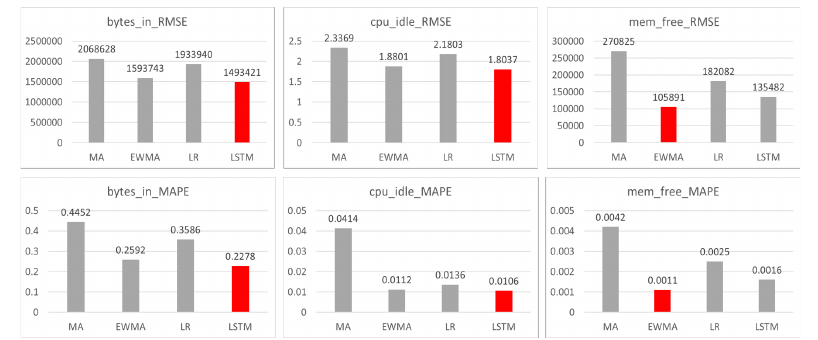
Figure 2. Prediction results. The left side of the figure shows the RMSE and MAPE of bytes_in_value. The middle diagram shows the RMSE and MAPE of cpu_idle_value. The right side of the figure shows the RMSE and MAPE of mem_free_value.